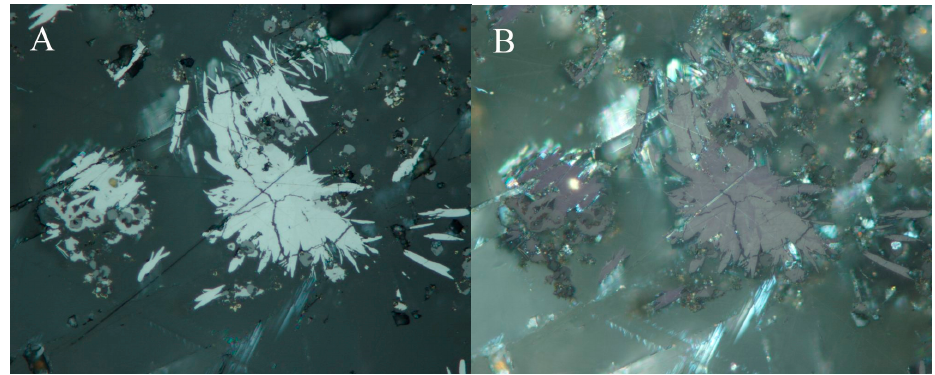
Figure 47. Lenticular euhedral grains of Se-rich chalcostibite (light grey), hakite (medium), and uraninite (dark grey) aggregates in calcite gangue. Reflected light, ( A ) one polarizer, and ( B ) partly-crossed polarizers. FOV 210 μ m. P ř íbram, a dump of shaft 16. Photo by P. Škácha.